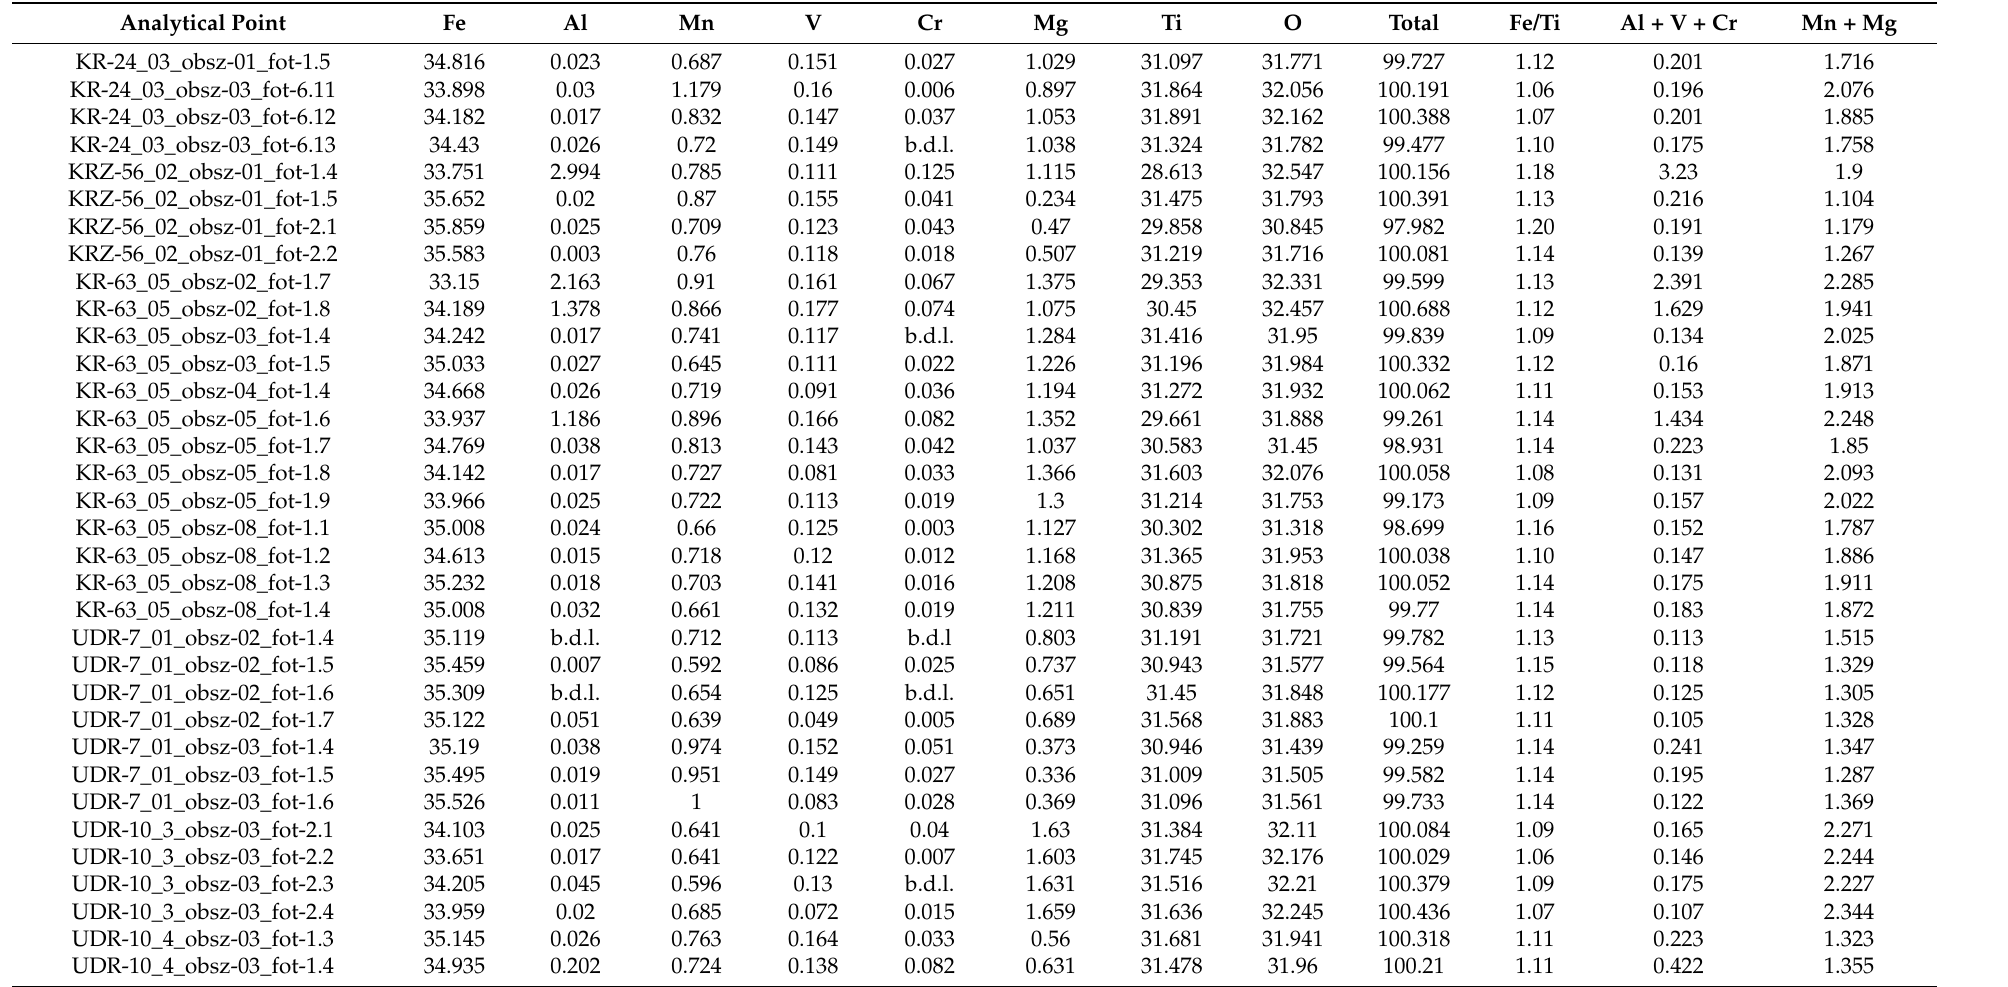
Table A2. Chemical composition of ilmenite from the Krzemianka and Udryn Fe-Ti-V deposits in NE Poland identified via